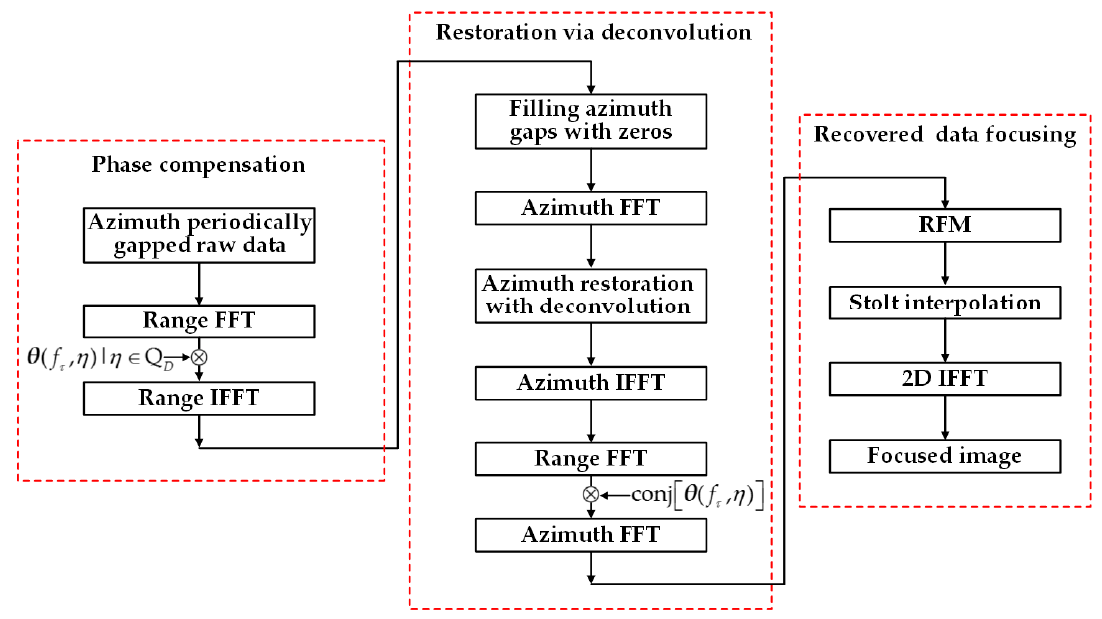
Figure 9. Flowchart of the proposed method.